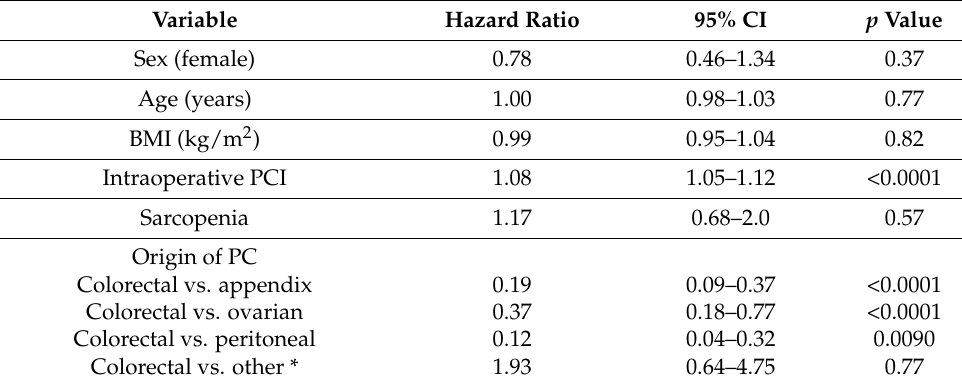
Table 4. Patient Survival (multivariate COX regression).